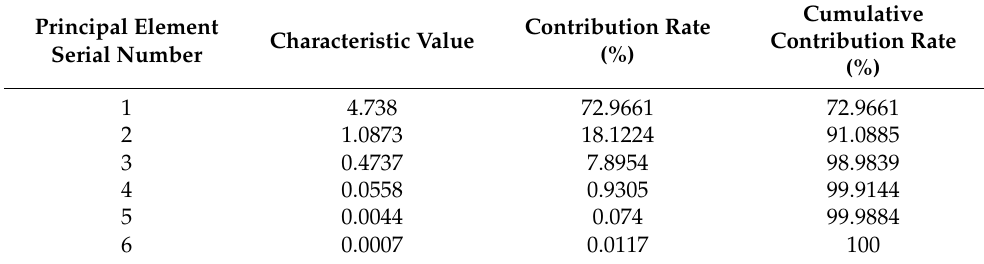
Table 1. Principal component contribution rate of battery